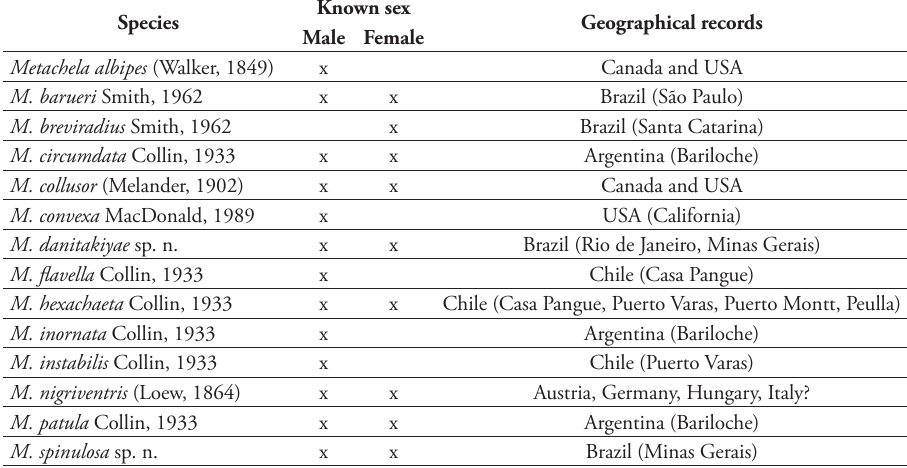
Geographical records